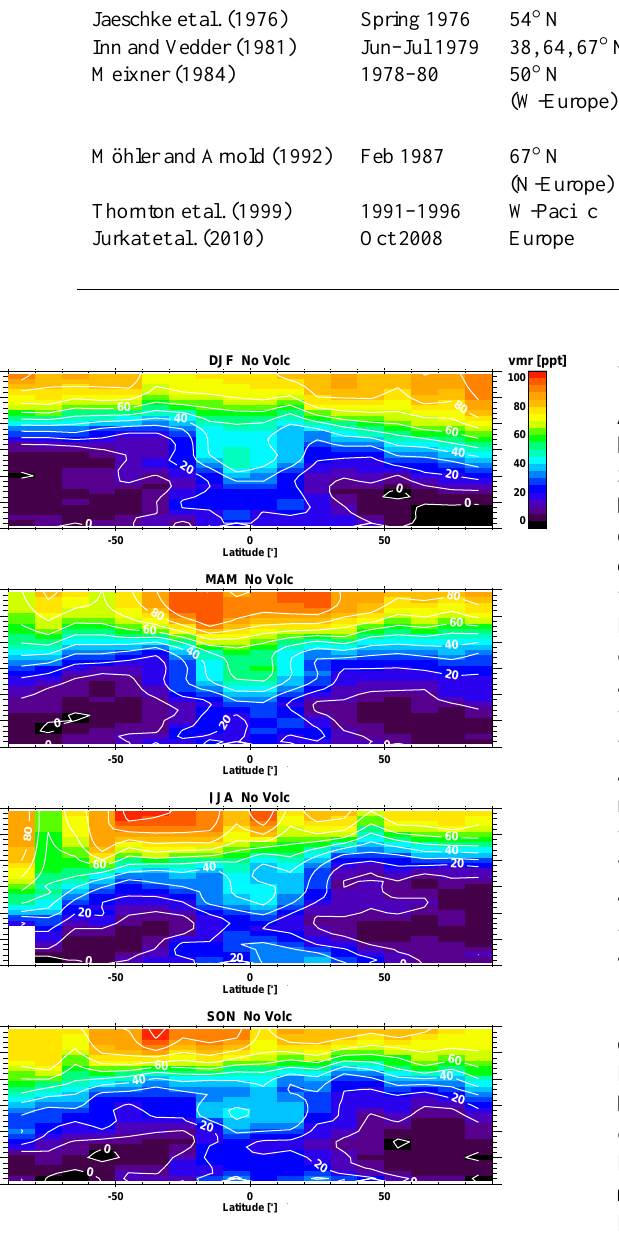
Fig. 7. Mean background seasonal distributions of SO 2 . Peri- ods of major volcanic influence that have been excluded